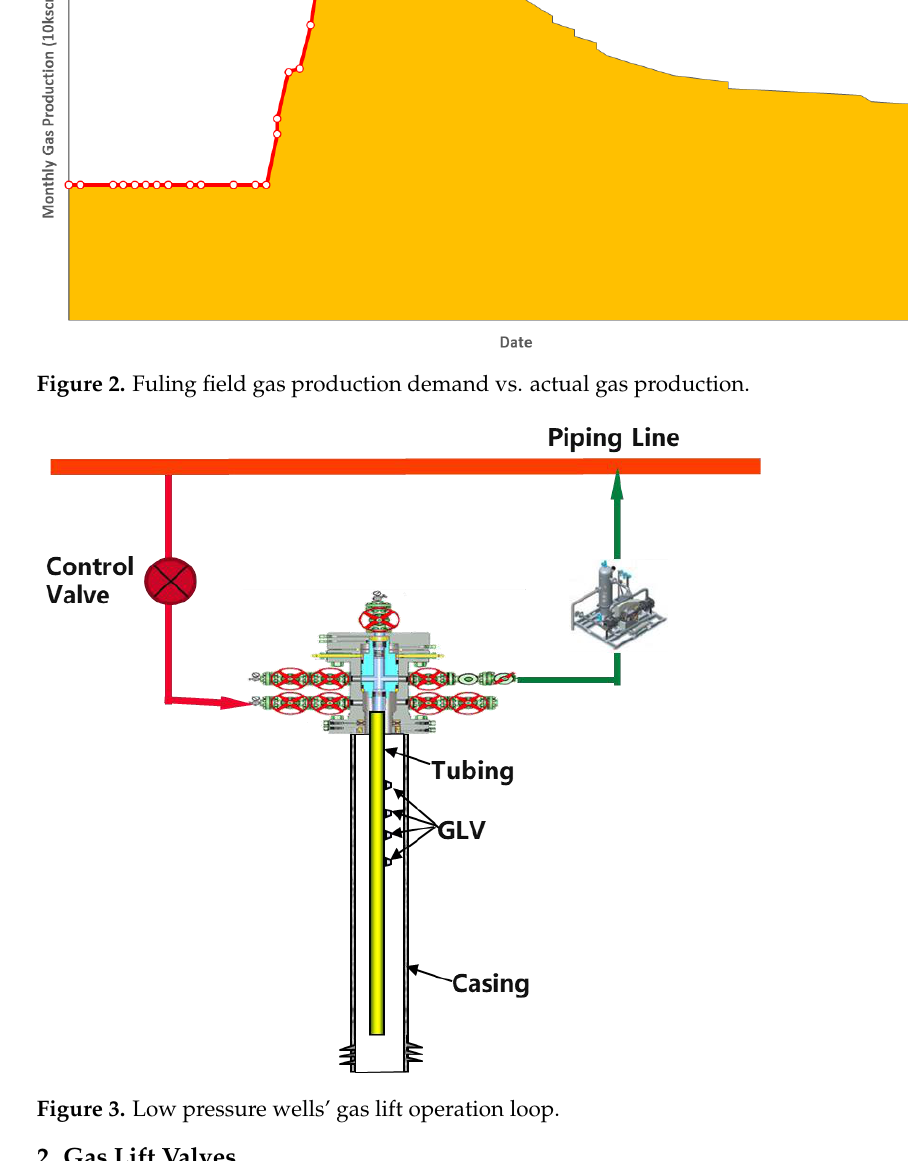
Figure 3. Low pressure wells’ gas lift operation loop.